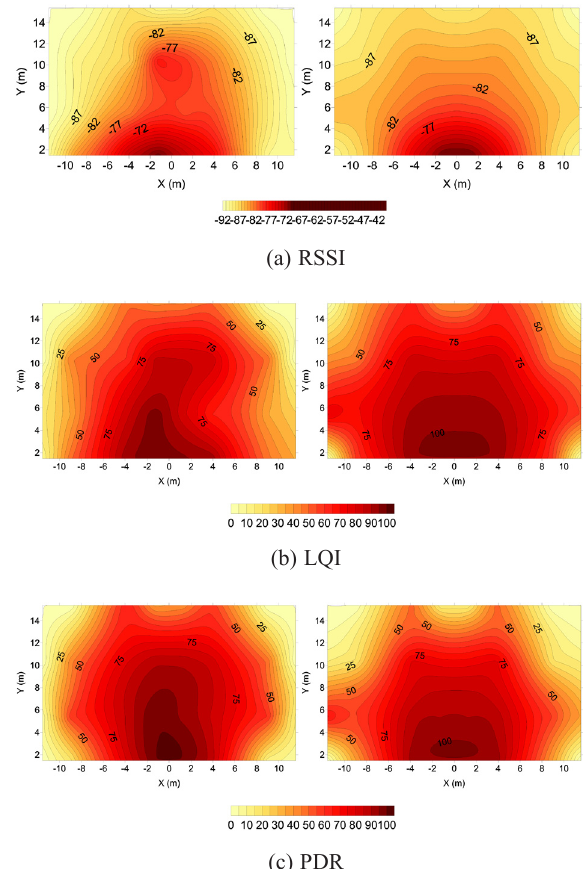
Fig. 8. Contour map for steel box girder bridge with the BS at center (left: measured and right: